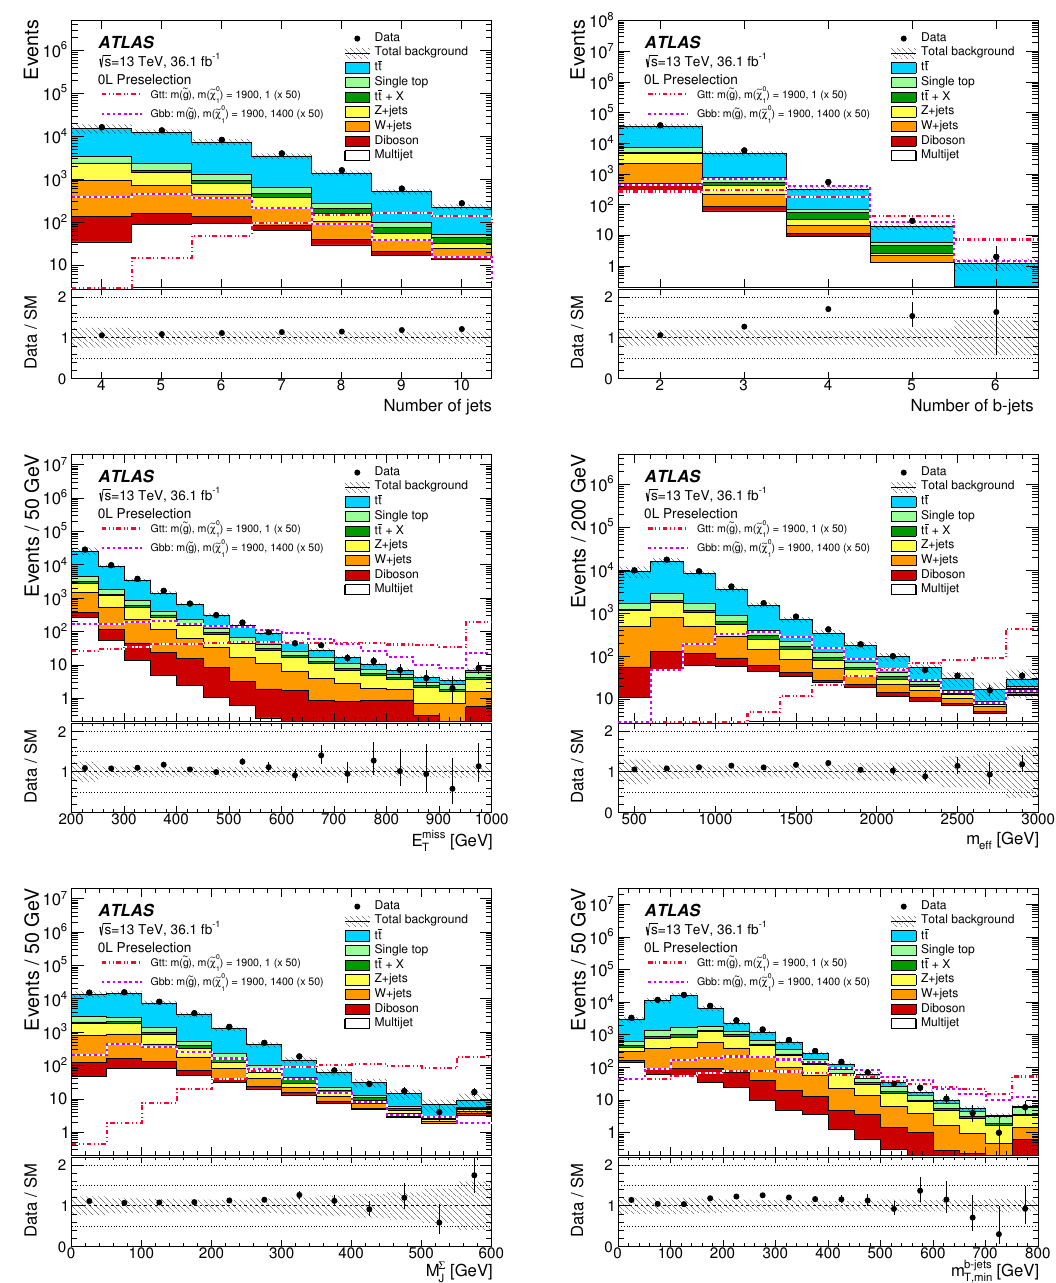
jet ), (top-right) the number of , (centre-right) m e(cid:11) , (bottom-left) M (cid:6) and J T